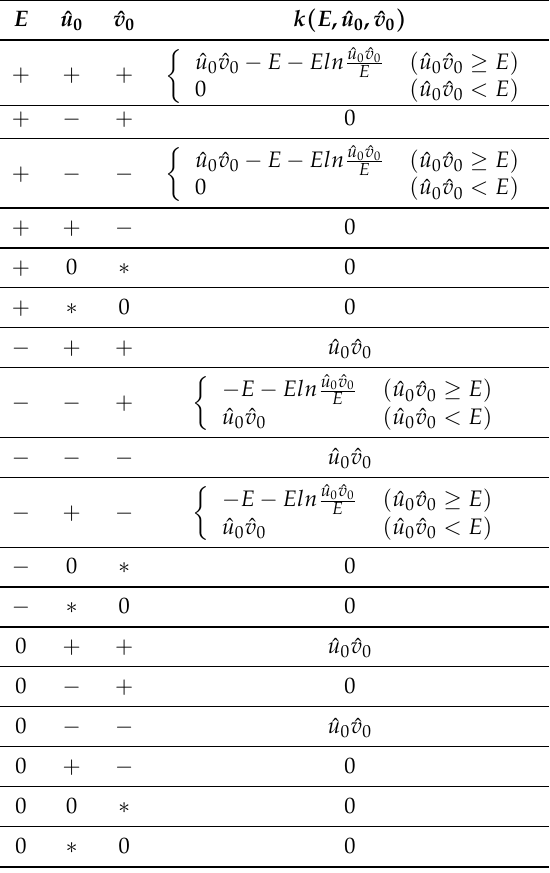
Table 1. The function value k ( E , ˆ u 0 , ˆ v 0 ) in different